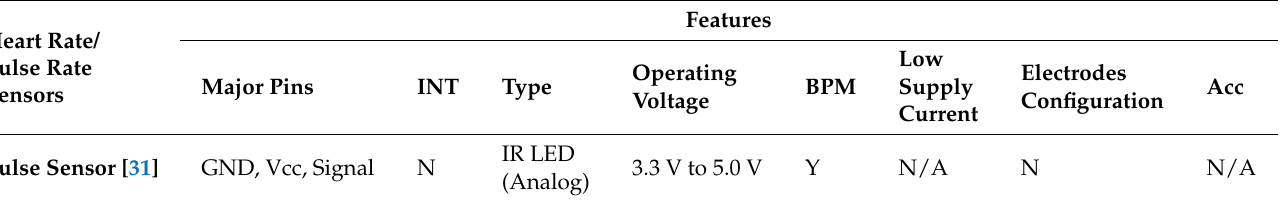
Table 5. Features of heart rate